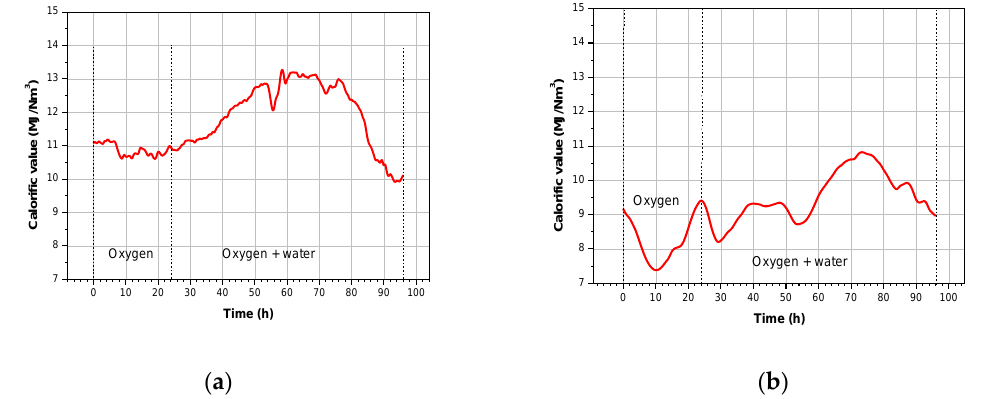
Figure 8. Changes in gas calorific value over the course of gasification experiments at 20 bar: ( a ) “Six Feet” semi-anthracite, ( b ) “Wesoła” hard coal.